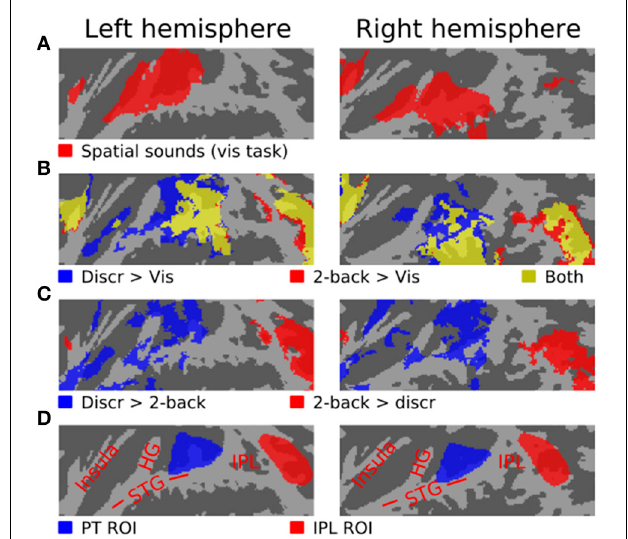
FIGURE 2 | Activations ( N = 17, threshold Z > 2 . 3, cluster-corrected P < 0 . 05) to spatial sounds shown on a flattened mean 2D cortical surface. (A) Results of contrast between activations during all visual task blocks (SD, SL or SR sounds) and during the 7s periods between task blocks with no stimuli. (B) Comparisons of activations during all discrimination (blue) and all 2-back task blocks (red) relative to rest. Areas where both contrasts were significant are shown in yellow. (C) Areas where activations were stronger during discrimination than 2-back tasks are shown in blue. The results of the opposite contrast (i.e., stronger 2-back activations) are shown in red. (D) Anatomical labels and ROIs. STG superior temporal gyrus, HG Heschl’s gyrus, IPL inferior parietal lobule.